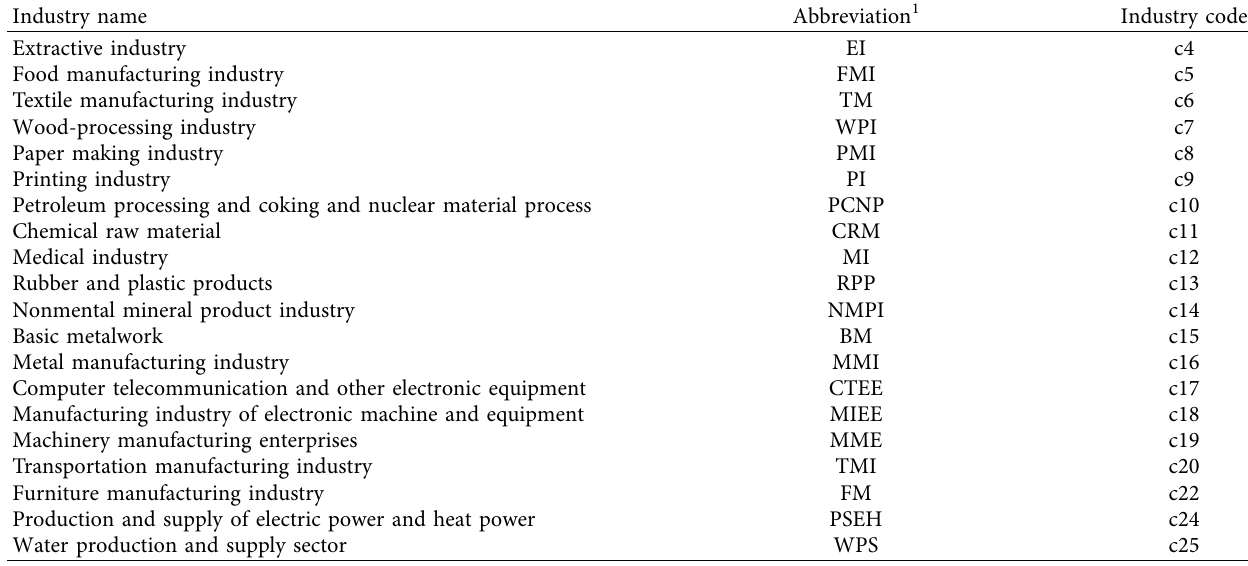
Table 1: Matched industries from multiple database sources.